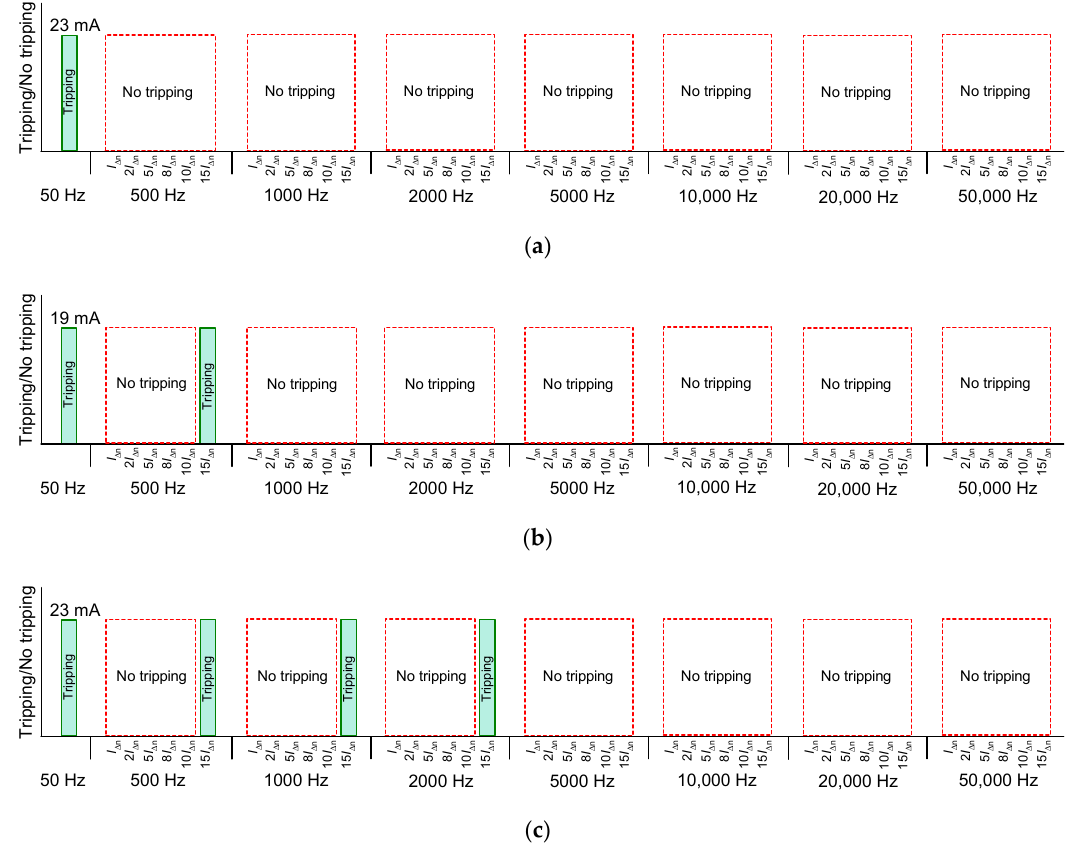
Figure 14. Tripping of the 30 mA A-type RCDs for a sine waveform of the specified frequency from 50 Hz to 50 kHz: ( a ) RCD_1A; ( b ) RCD_2A; ( c ) RCD_3A; symbols defined in Table 2.